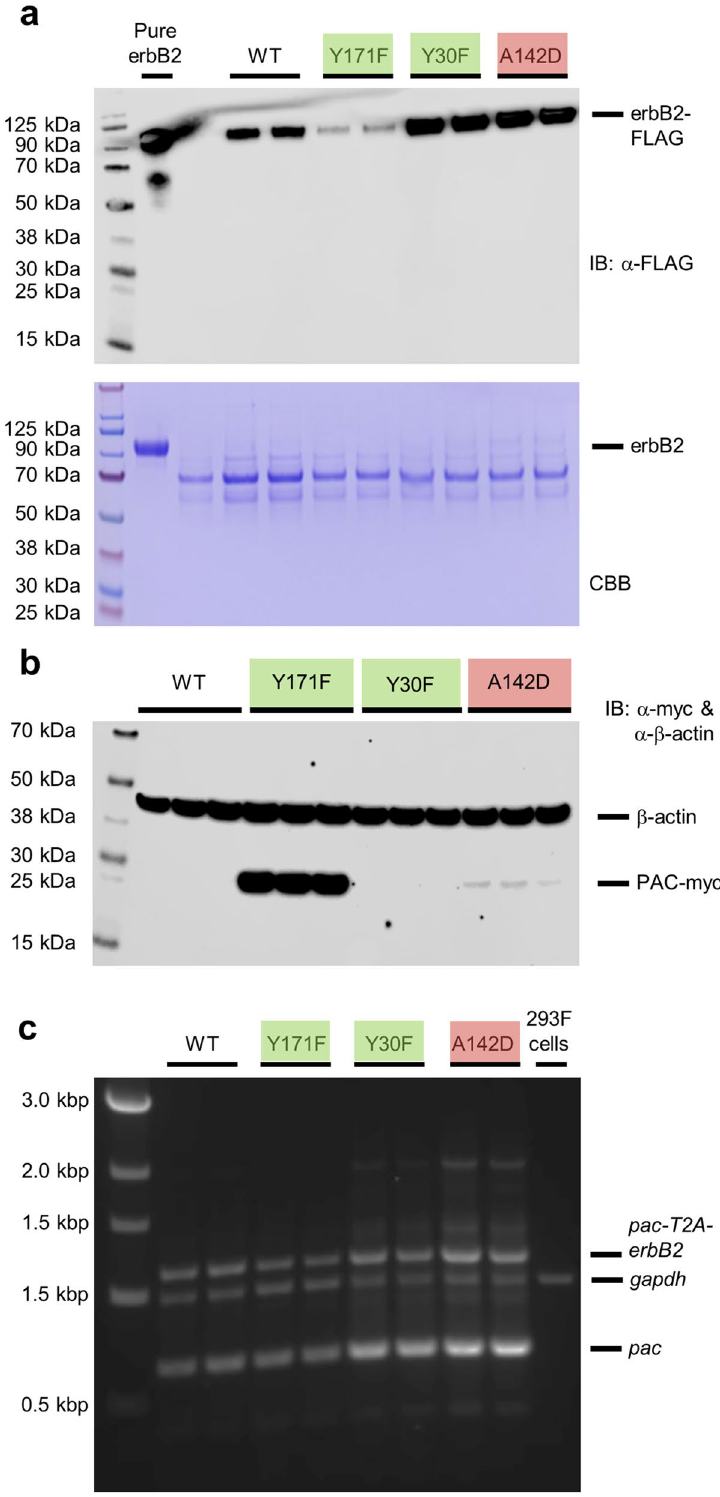
Figure 4. Assessment of stably transfected HEK293-F pools derived with the wild-type and mutant pac-T2A- erbB2 cassettes at the protein and RNA levels. ( a ) Verification of ErbB2 molecular weight by immunoblotting and Coomassie Brilliant Blue stained gels of culture supernatants used for ELISA studies. ( b ) Intracellular expression of myc-tagged PAC relative to the β-actin loading control. ( c ) A multiplexed reverse transcriptase PCR of the pac-T2A-erbB2 transcript from isolated cellular RNA. Replicates are of individual wells grown and processed in parallel and are carried out in triplicate in ( a , b ) and duplicate in ( c ). Colour coding is consistent with the classes of mutations described in Fig.